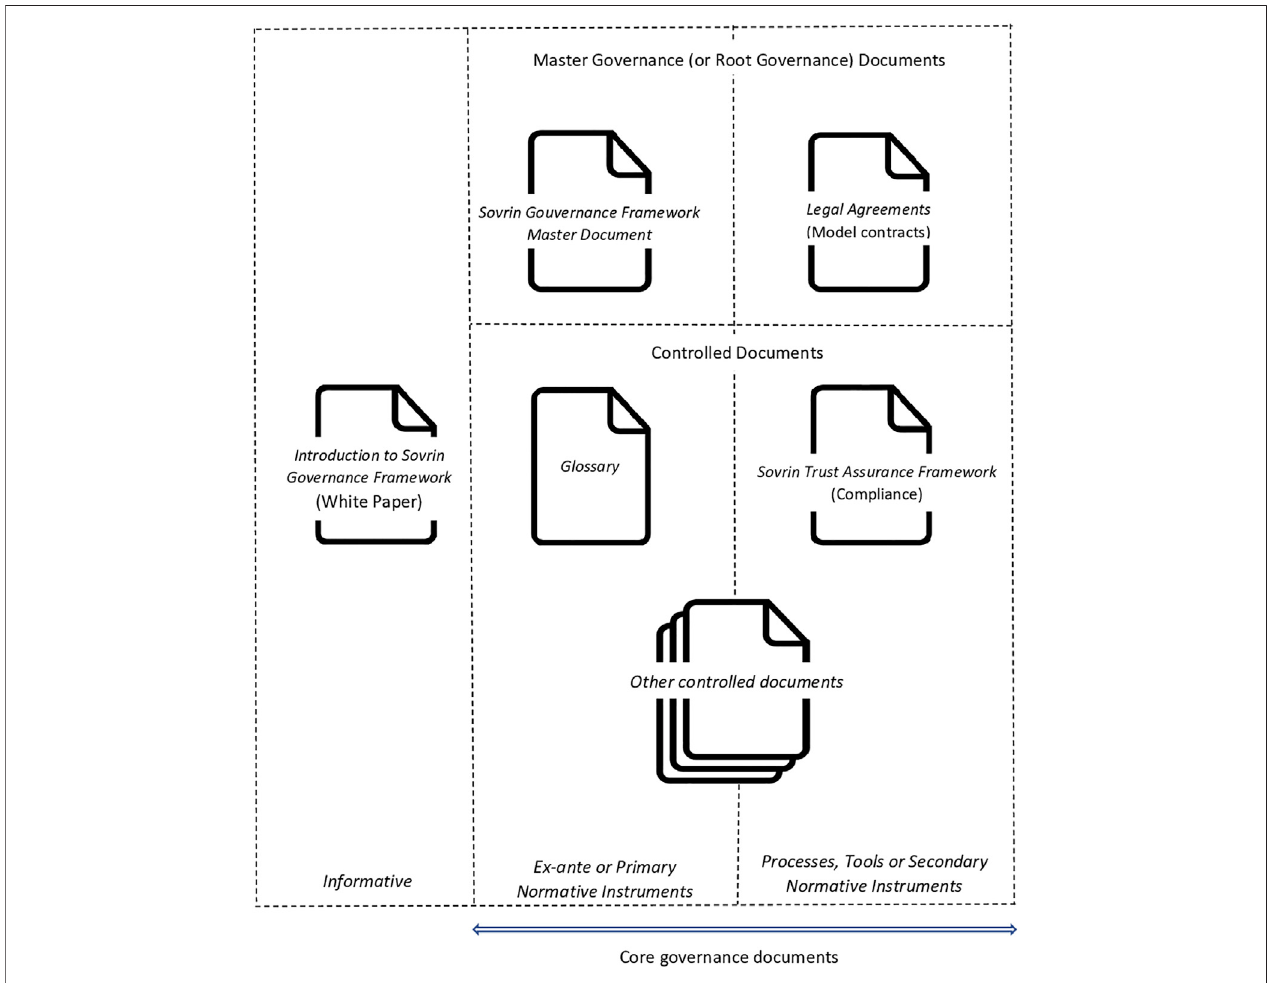
FIGURE 2 | Categorization of Sovrin governance framework